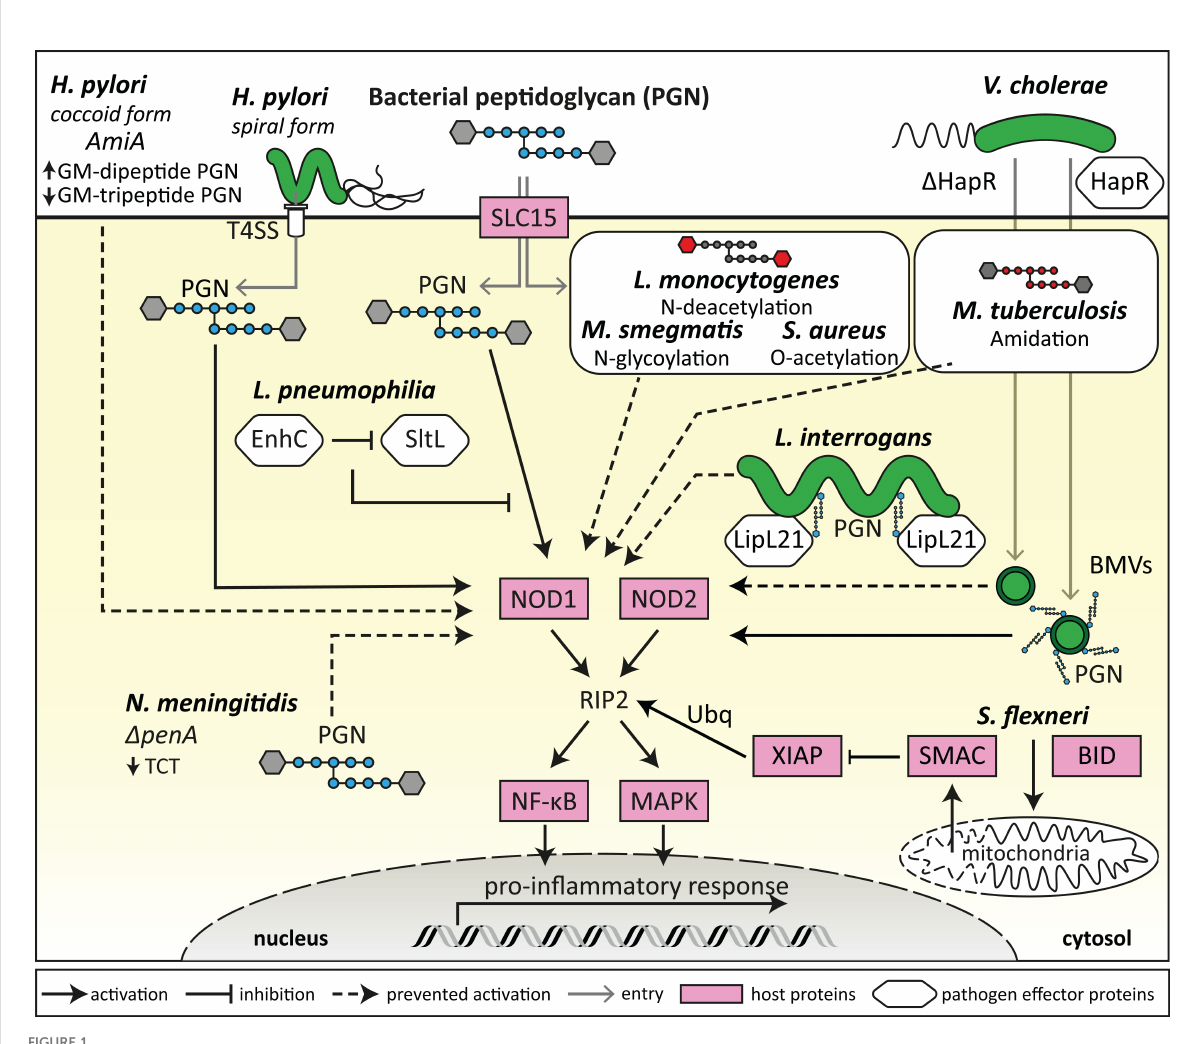
FIGURE 1 Bacterial evasion of NOD1 and NOD2 detection. Bacteria can modify their morphology and metabolism to evade detection by NODs by a range of mechanisms. This includes H. pylori transitioning from spiral to coccoid morphology, which results in decreased GM-tripeptide accumulation, and deletion of penA by N. meningitidis which results in decreased TCT tetrapeptide peptidoglycan (PGN) moieties, ultimately reducing the availability of NOD ligands to prevent NOD1 activation. Some bacteria express proteins that can block the enzymatic release of speci fi c NOD- activating PGN moieties ( L. pneumophila ) or can sequester NOD ligands to the bacterial surface ( L. interrogans ), thus preventing NOD1 and NOD2 activation. Several bacterial strains, such as S. aureus, M. tuberculosis, M. smegmatis and L. monocytogenes , have processes to modify their PGN in order to evade NOD1/2 detection and activation, resulting in an attenuated proin fl ammatory response. Bacteria also release bacterial membrane vesicles (BMVs) containing PGN that can activate NODs, and bacterial expression of proteins such as HapR ( V. cholerae ) can alter the PGN content of BMVs and therefore modulate NOD1 and NOD2 activation. Bacteria such as S. fl exneri can induce BID-dependent selective permeability of the mitochondria, resulting in the release of SMAC, which blocks XIAP ubiquitination of RIP2 downstream of NOD1 and NOD2